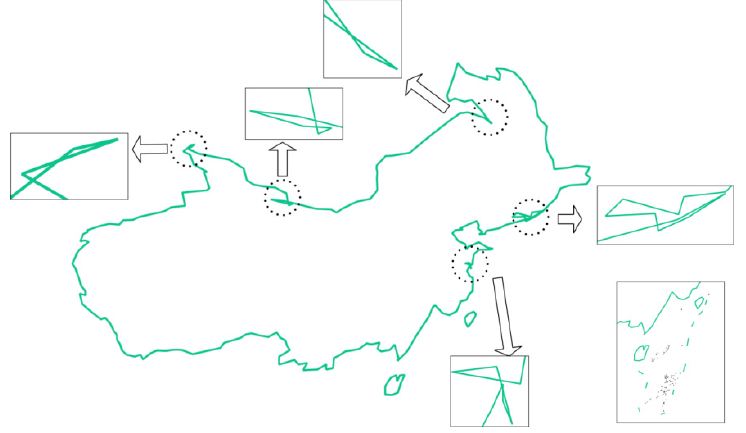
Figure 4. Topological errors in transformed boundary (Maps in this figure are demonstrations of experiment results, not the real territory of the study area).